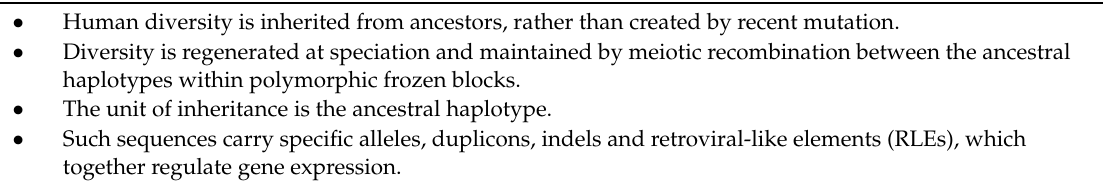
Table 1. Lessons from MHC genomics.